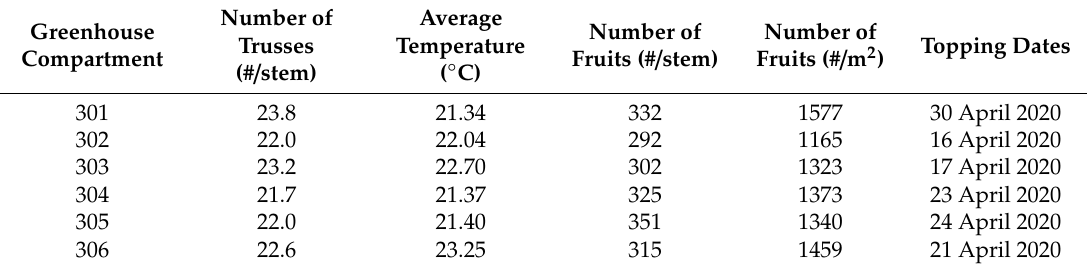
Table 1. Final number of trusses (# / stem) and number of fruits (# / stem, # / m 2 ), average air temperature and topping dates in di ff erent greenhouse compartments (301–306), planting date 16 December